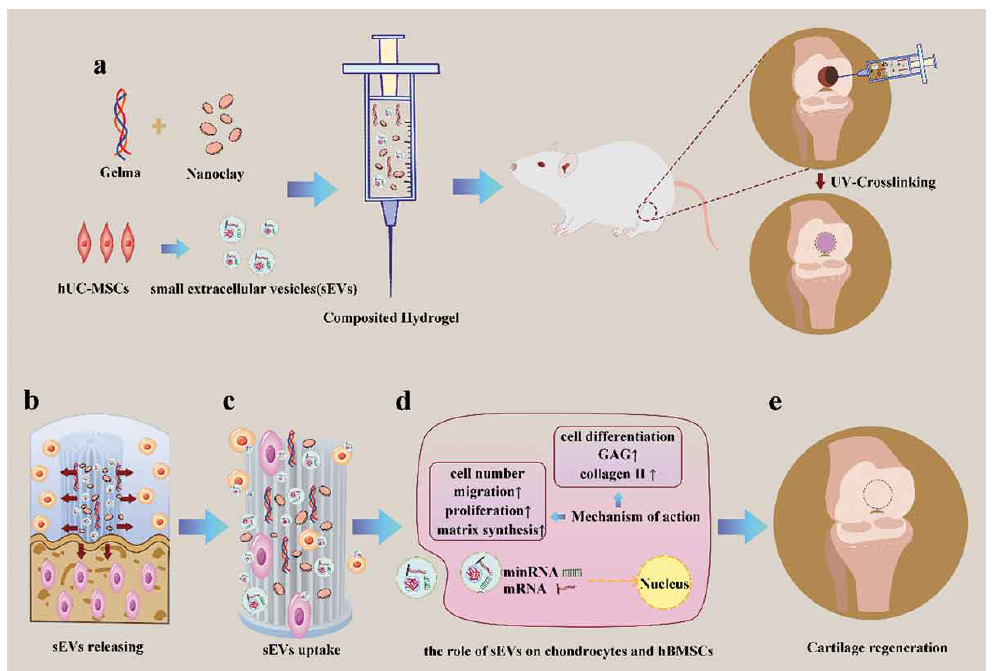
Figure 2. Schematic illustration of therapeutic sEVs released from a GelMA/nanoclay hydrogel for cartilage regeneration. ( a ) Preparation of a GelMA/nanoclay/sEV hydrogel and cartilage defect implantation. ( b ) Sustained release of sEVs with the degradation of the hydrogel. ( c ) Internalization of therapeutic sEVs by chondrocytes and hBMSCs. ( d ) The effect of the EVs on chondrocytes and hBMSCs. ( e ) Regeneration of a cartilage defect by the composite hydrogel. Copyright 2020, with permission from John Wiley and Sons [31] .